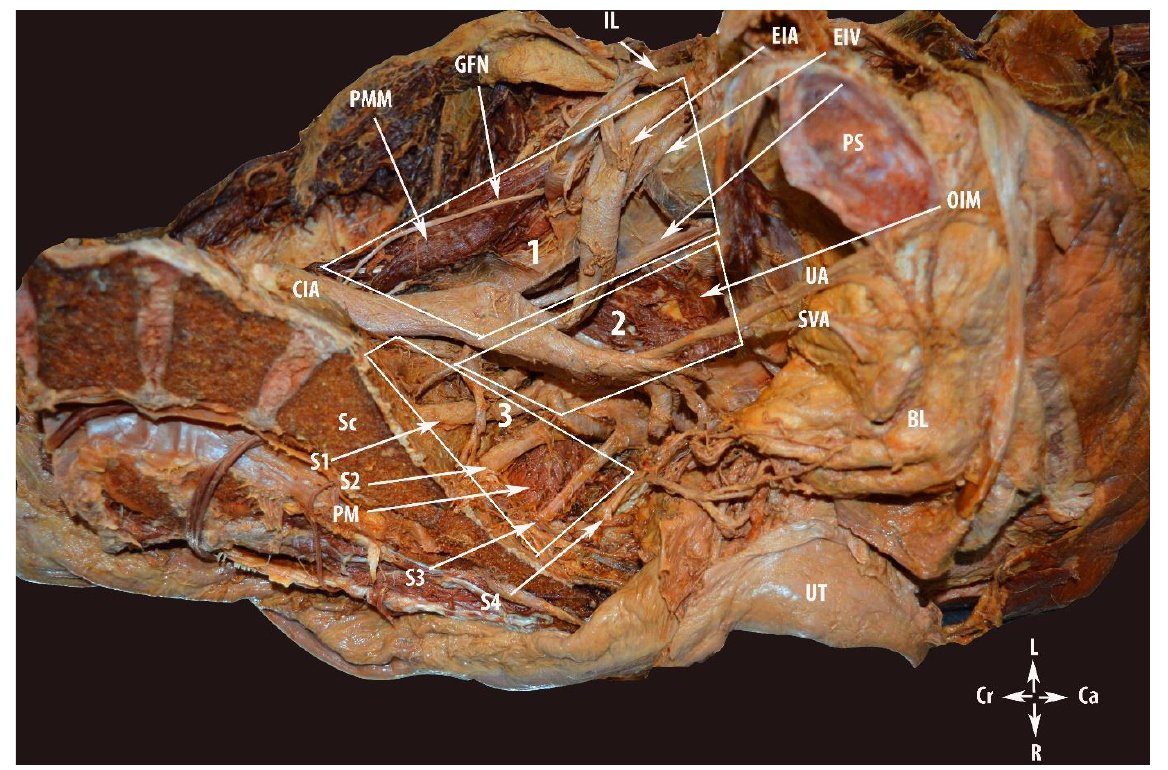
Figure 1. Regions of the pelvic sidewall in gynecology: 1 — avascular region; 2 — vascular region;